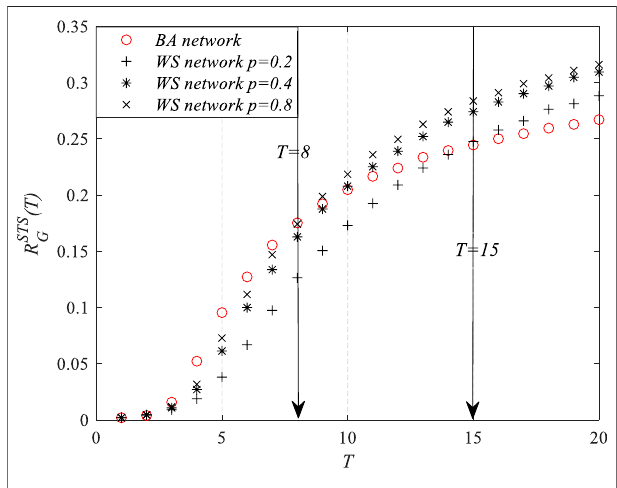
FIGURE 5 | The robustness of homogeneous networks at time T with respect to the susceptible – infected – susceptible (SIS) epidemic spread.